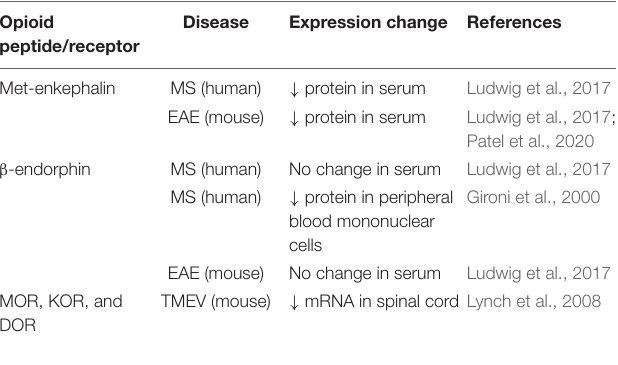
TABLE 1 | Changes in endogenous opioid peptide and receptor expression in MS patients and animal models. Opioid peptide/receptor